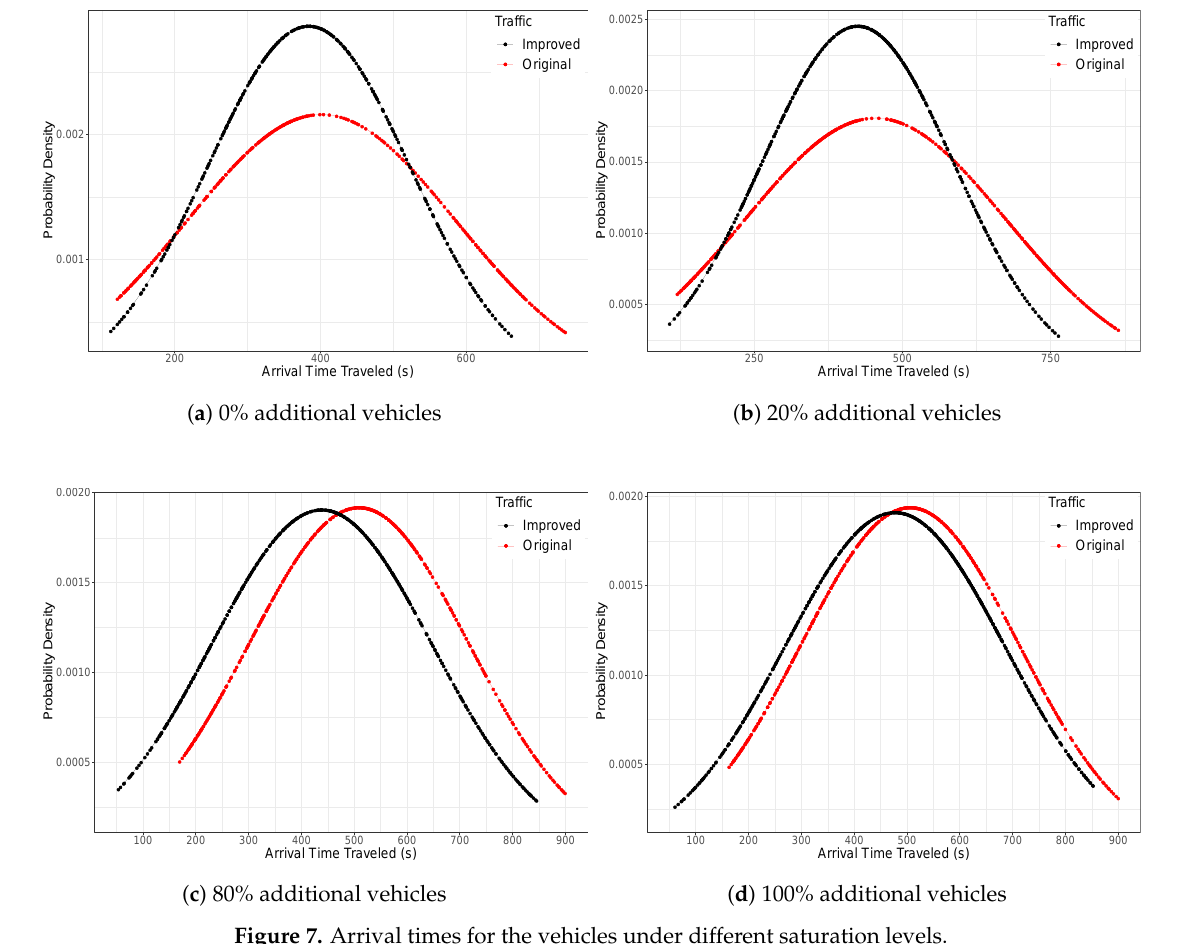
Figure 7. Arrival times for the vehicles under different saturation